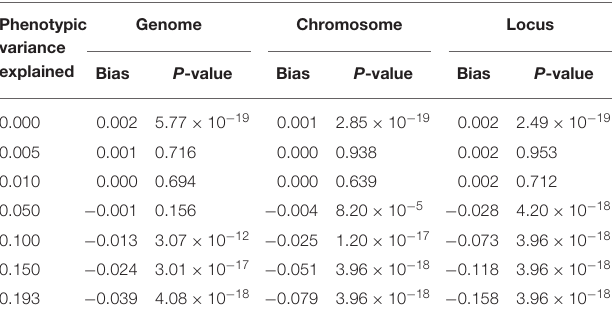
TABLE 1 | Bias in genome partitioning using GCTA.